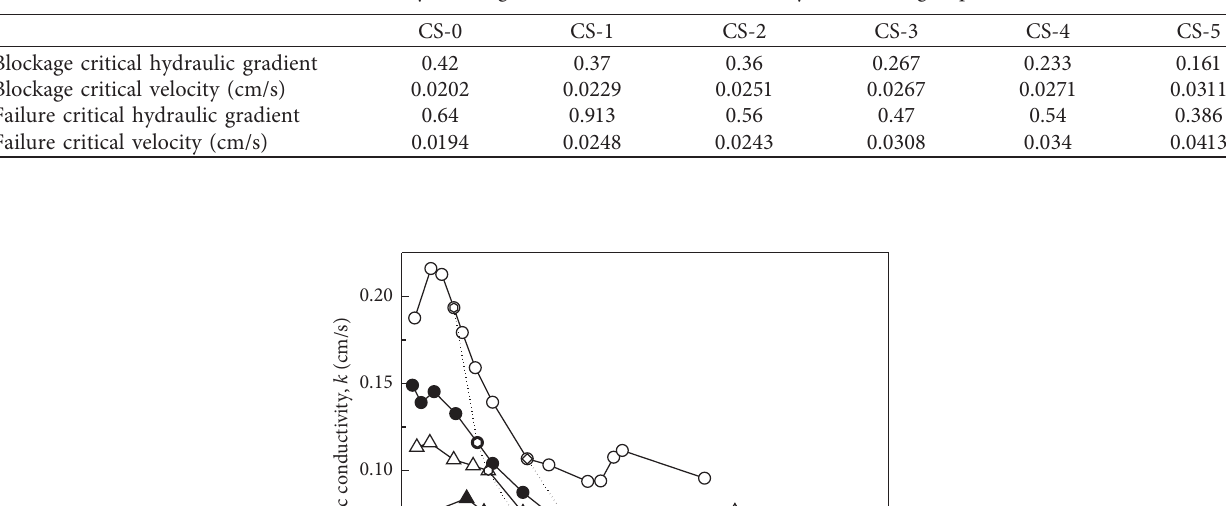
Table 6: Critical hydraulic gradient and critical flow velocity for the CS group.